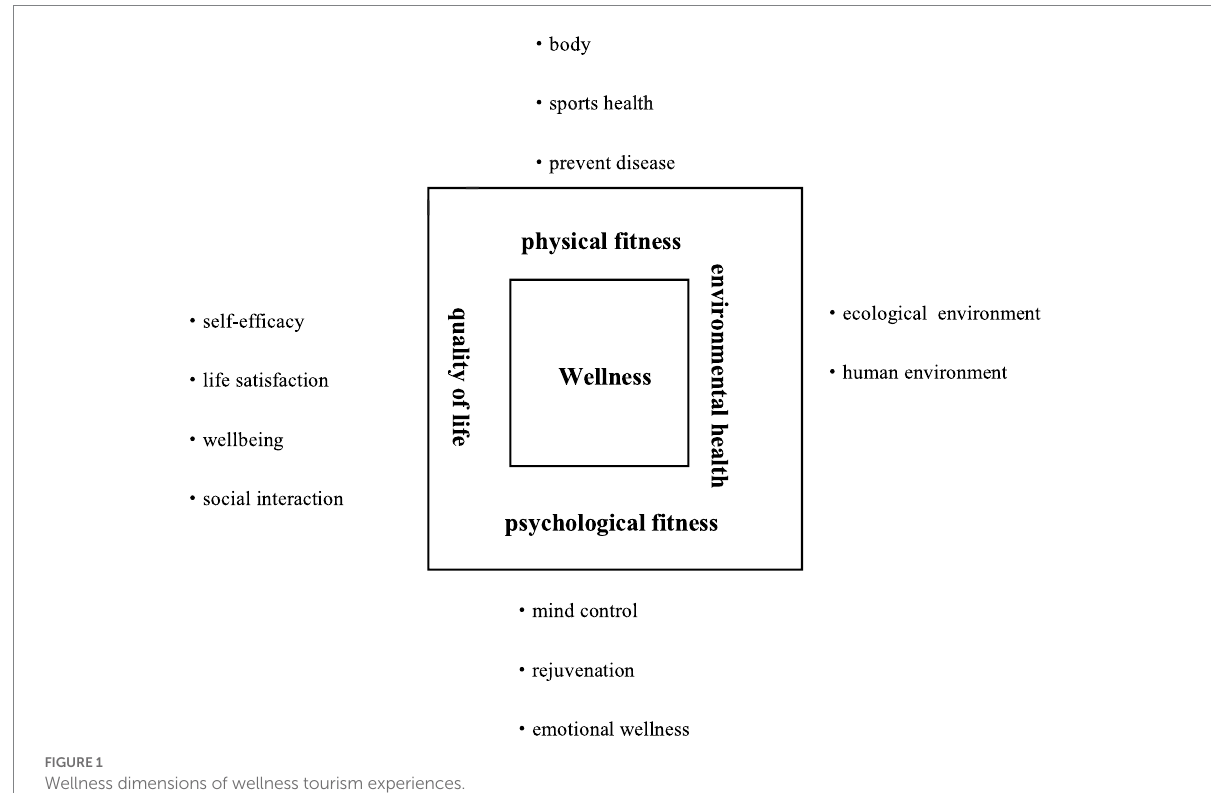
FIGURE 1 Wellness dimensions of wellness tourism